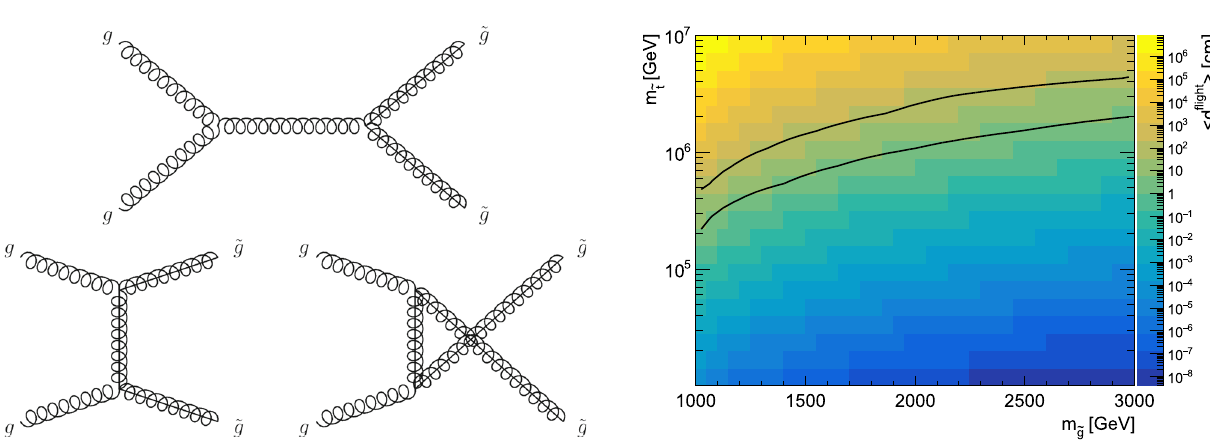
g and the stop mass m ˜ t for a = 250 GeV and ˜ χ 0 = ˜ B . The 1 1